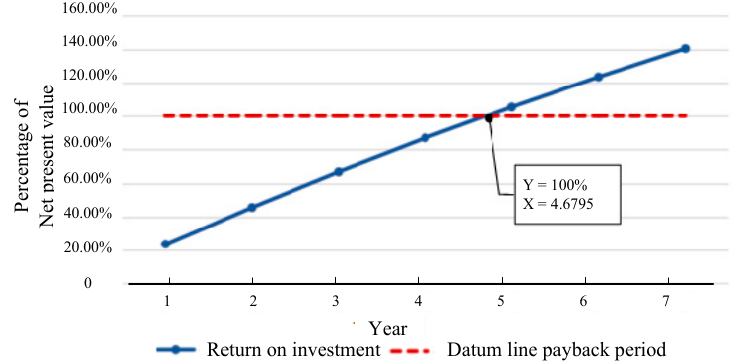
Figure 5. Return on investment curve under dynamic analysis.